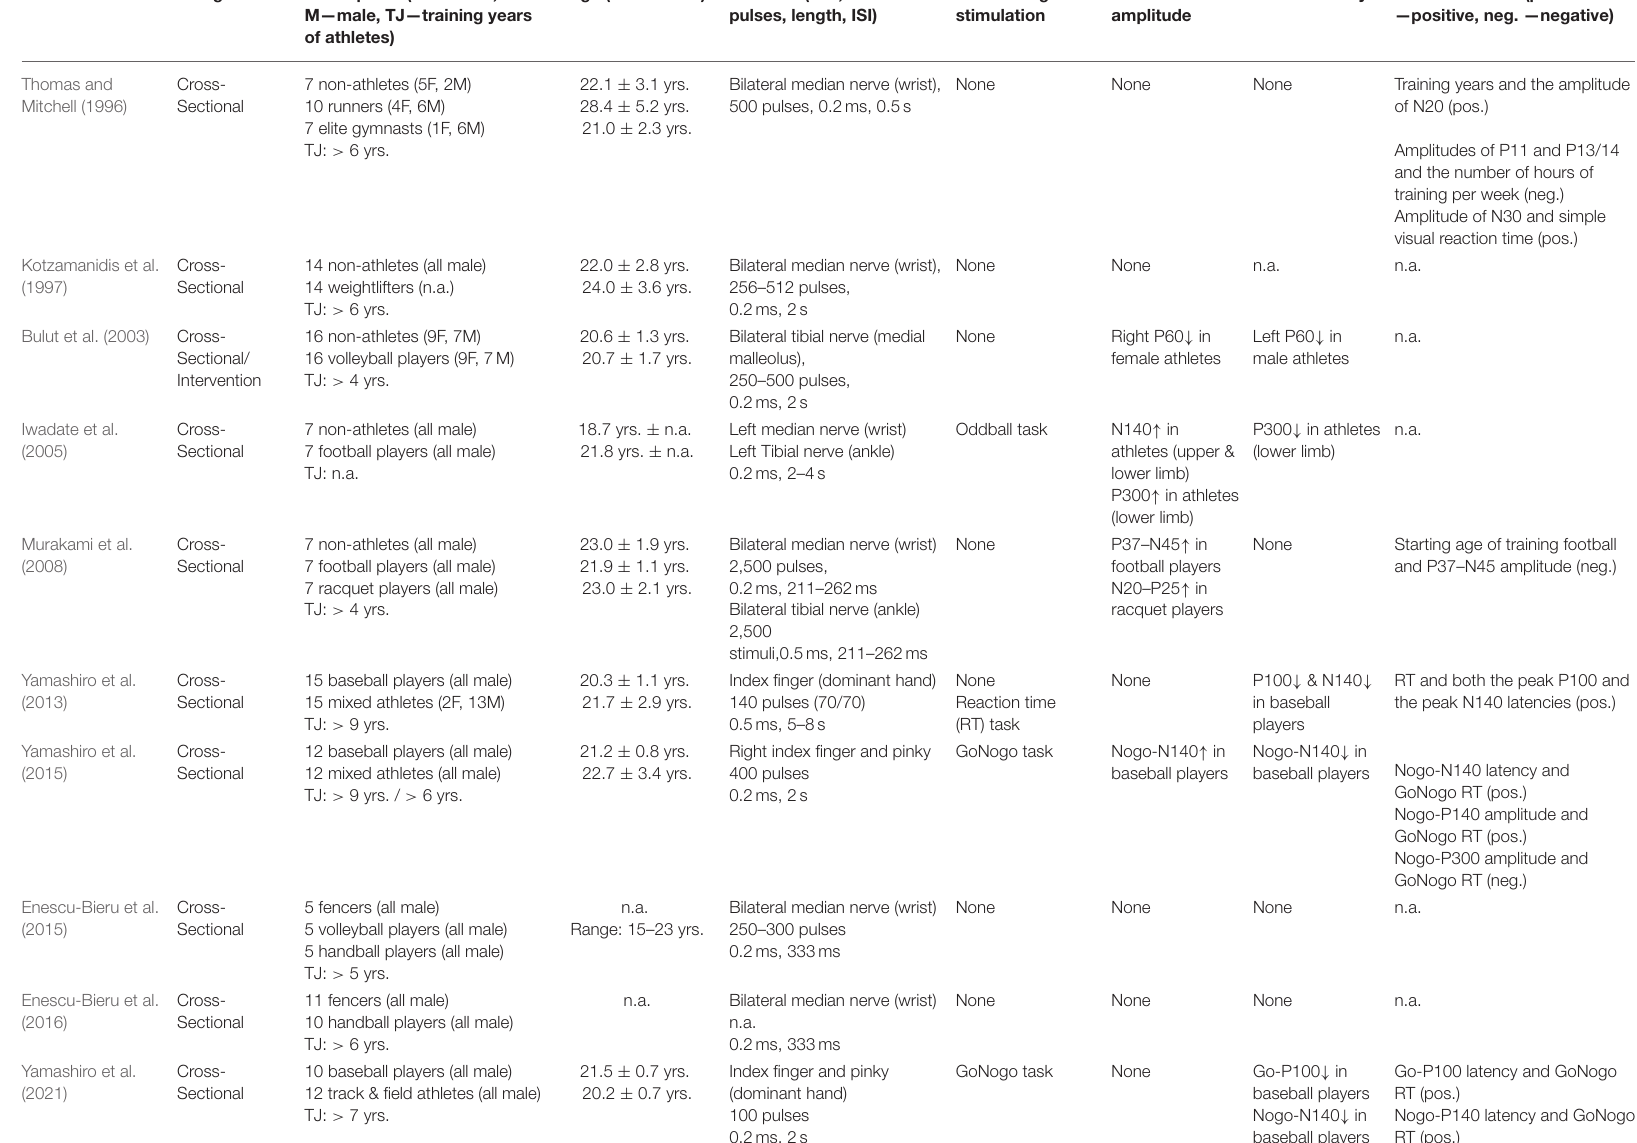
TABLE 1 | Overview of studies investigating athletes’ SEP